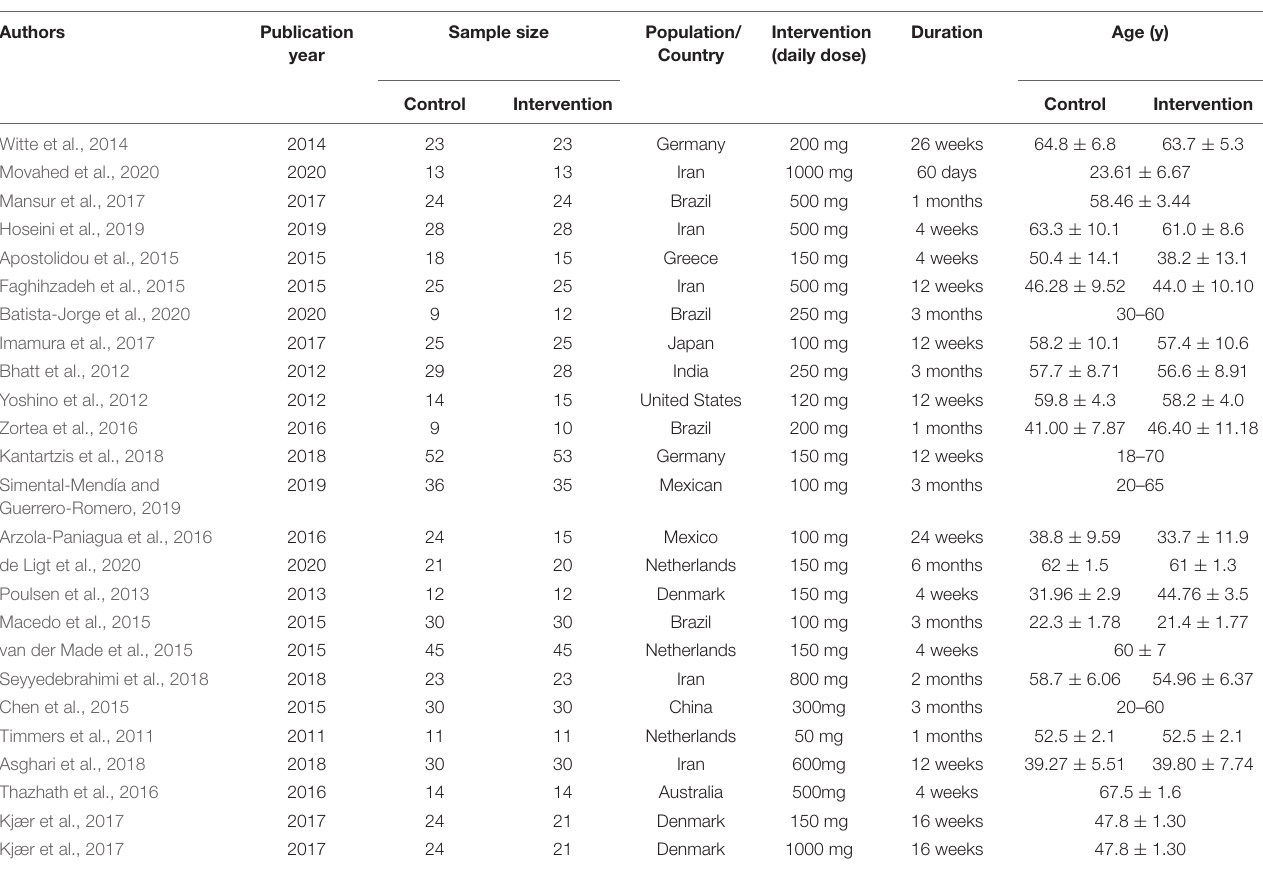
TABLE 1 | Characteristics of included